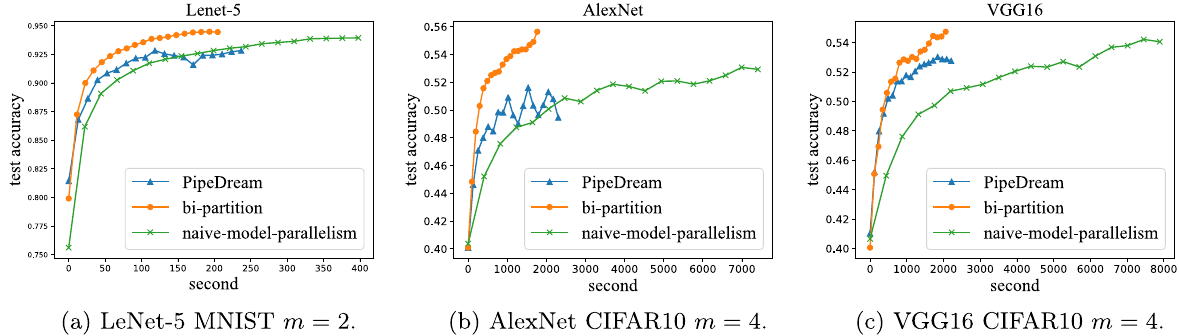
Fig. 9 Test accuracy vs. Training time on LeNet-5, AlexNet and VGG16 compared to naive-model-parallelism and